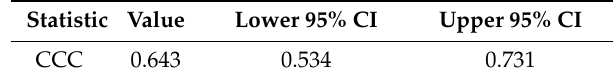
Table 4. Bland–Altman statistics for Zephyr ECT vs. Gold Standard.